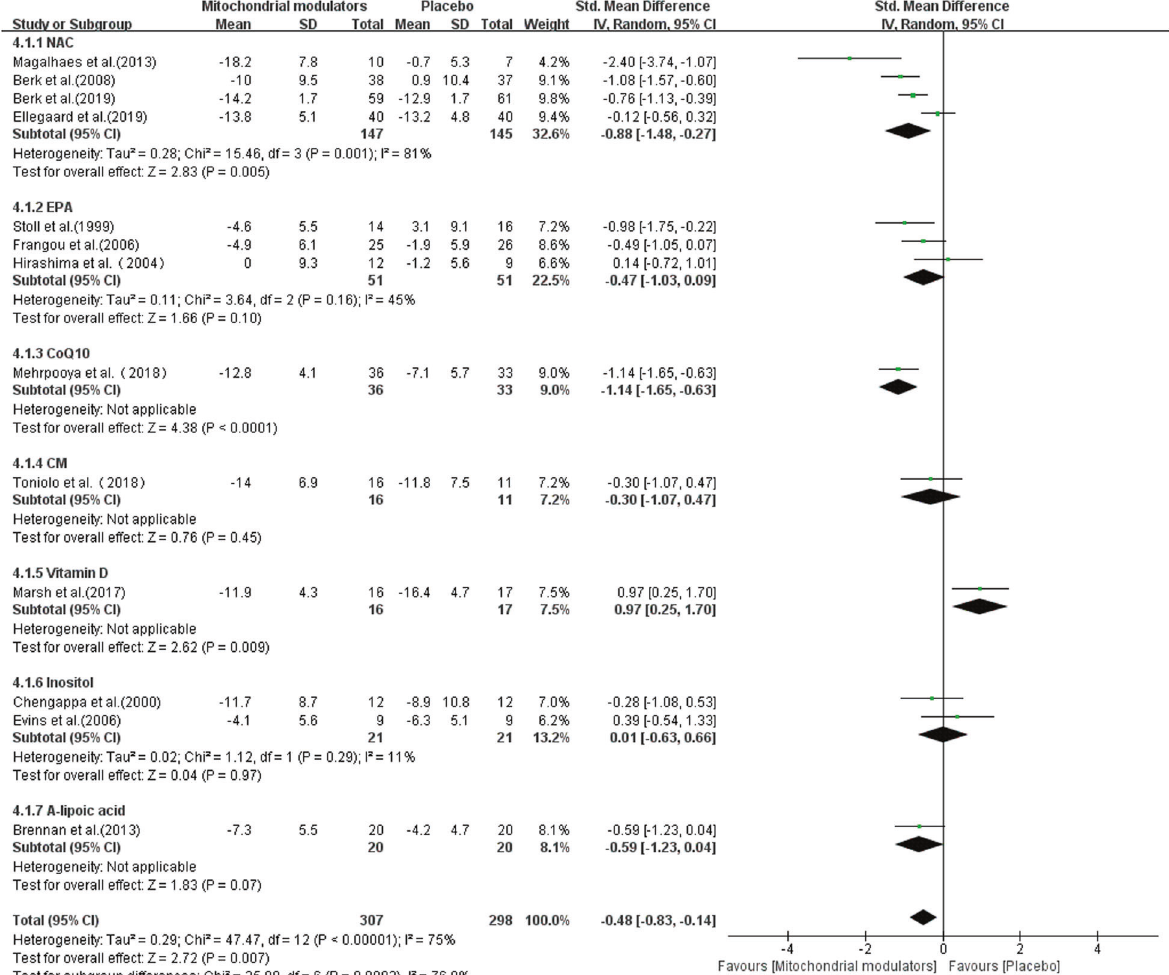
Fig. 3 Forest plot of pooled effect sizes of mitochondrial modulators for bipolar depression. CoQ10 Coenzyme Q10, CM creatine monohydrate, EPA eicosapentaenoic acid, NAC N-acetylcysteine, SD standard deviation, SMD standard mean